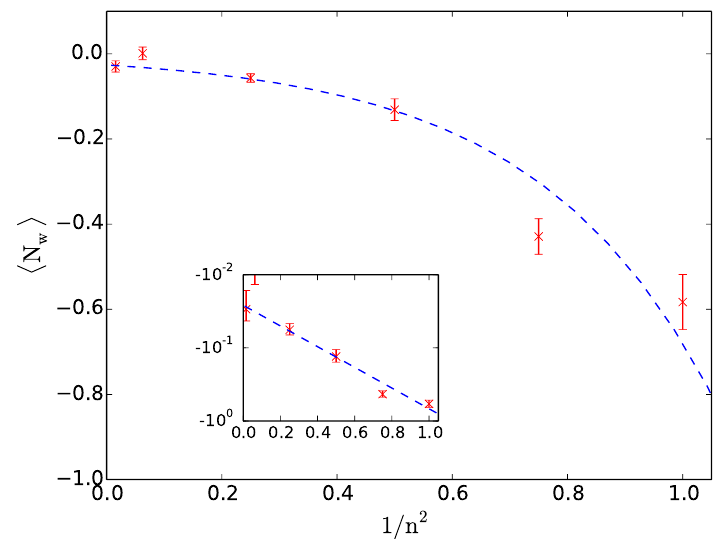
Figure 7 . The asymmetry as a function of energy in the system. Overlaid, an exponential (cid:12)t (see main text). Insert: the same but on a log-scale.